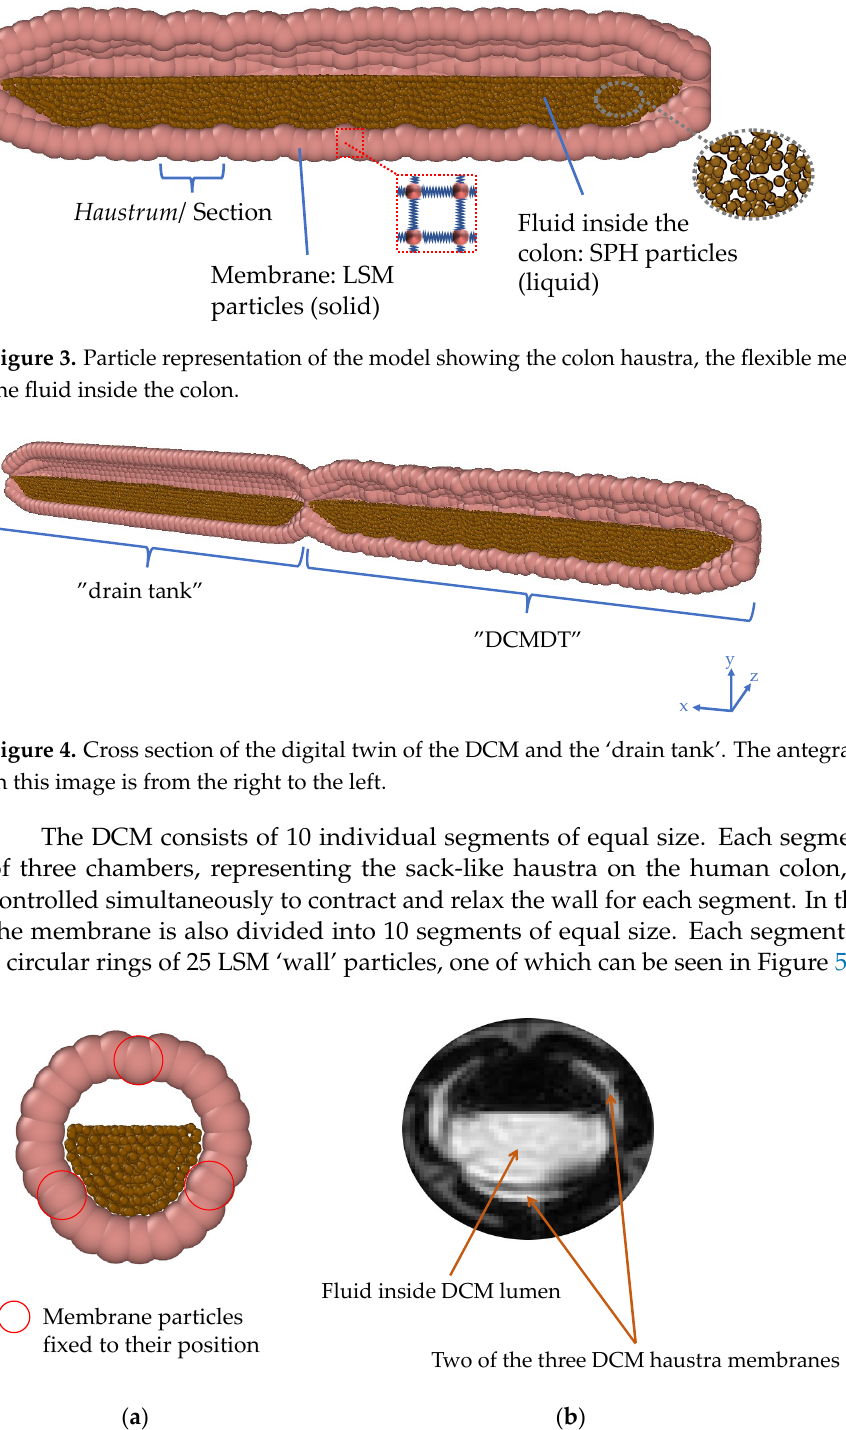
Figure 4. Cross section of the digital twin of the DCM and the ‘drain tank’. The antegrade direction in this image is from the right to the left.